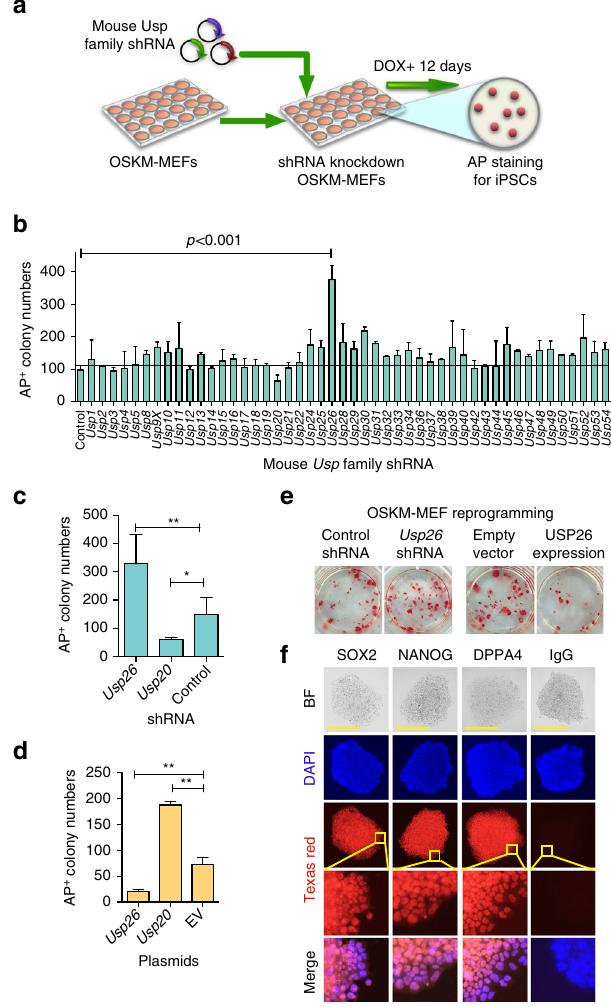
Fig. 1 Identi fi cation of USP26 as a negative regulator of pluripotency. a Schematic of experimental strategy for screening essential Usps for the generation of iPSCs. Dox-inducible OSKM-transgenic MEFs were plated, transfected with 48 individual mouse Usp shRNA lentiviral vectors to knockdown Usps , and stained for AP + iPSC colonies after 12 days of Dox treatment. b Quanti fi cation of AP + colonies after 12 days of OSKM induction in MEFs transduced with shRNA, targeting members of the mouse Usp family, p < 0.001 compared to control shRNA. c Quanti fi cation of AP + colonies after 12 days of OSKM induction in MEFs transduced with mouse Usp26 shRNA, Usp20 shRNA, or control shRNA lentivirus, * p < 0.05 compared to control shRNA, ** p < 0.01 compared to control shRNA. d Quanti fi cation of AP + colonies after 12 days of OSKM induction in MEFs transduced with pLtet-O (tetracycline-inducible) mouse Usp26 , Usp20 , or empty vector (EV) lentivirus, ** p < 0.01 compared to EV. e Images of AP staining of iPSC colonies after 12 days ’ OSKM induction in MEFs transduced with control shRNA, Usp26 shRNA, EV, or pLtet-O lentivirus overexpressing Usp26 . f Bright fi eld (BF) and immuno fl uorescence microscopic images of Oct4, Nanog, and Dppa4 in Usp26 knockdown iPSCs. iPSC colonies were fi xed, blocked, and stained with speci fi c antibodies, followed by goat anti-mouse antibody-conjugated Texas Red. Nuclei were stained with DAPI. Scale bar , 100 µ M. The data are presented as means ± SD from three independent experiments. b – d Two-way ANOVA for multiple